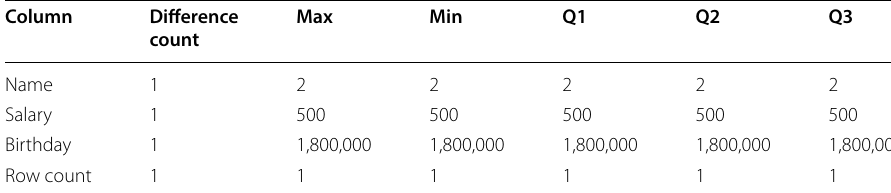
Table 7 Column validation statistics—“Users" table